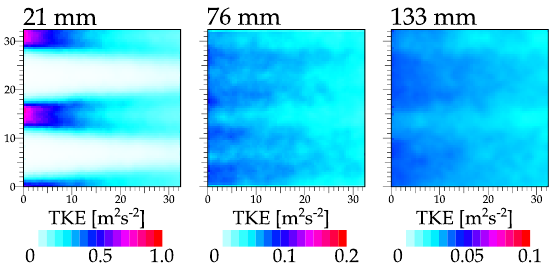
Fig. 3. Spatial distribution of the turbulent kinetic energy. Stream-wise velocity is 3 . 0m / s, corresponding Re = 3 . 1 · 10 3 .